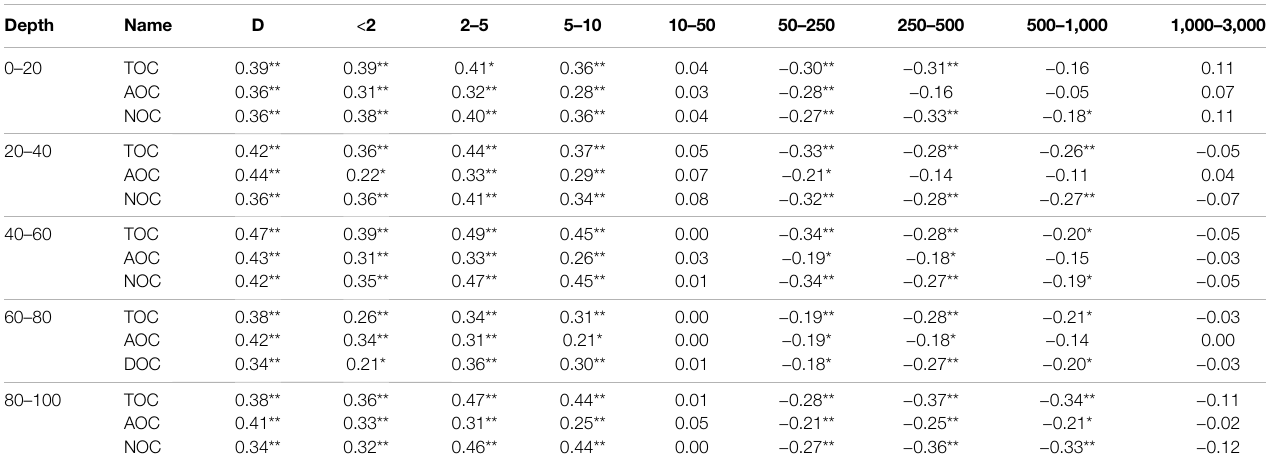
TABLE 4 | Correlation analysis between the soil particles and SOC in the farmland in the non fl ooded area.